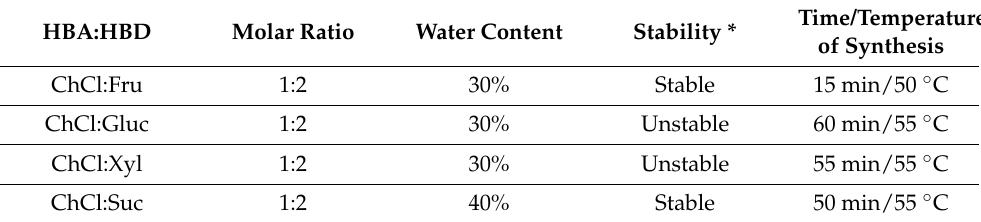
Table 1. List of natural deep eutectic solvents (NADES) prepared in this work and the corresponding molar ratio of hydrogen bond acceptor (HBA) and hydrogen bond donor (HBD), water content, as well as stability, time, and temperature of the